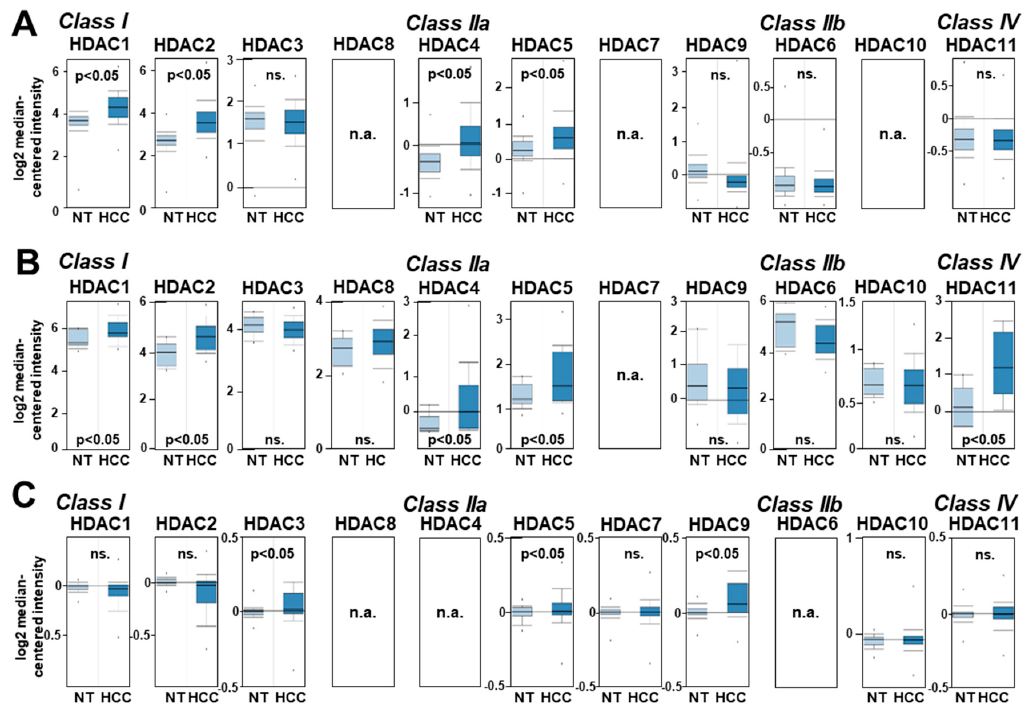
Figure 2. HDAC expression in human HCC compared with non-tumorous liver tissues. ( A–C ) HDAC mRNA levels in non-tumorous liver tissues (NTs) as compared to HCC tissues from patients. Data were obtained from the Oncomine TM cancer microarray database using the datasets ‘Roessler Liver2’ (n = 445) (C), ‘Wurmbach Liver’ (n = 75) (D), and ‘Guichard Liver’ (n = 185) (E). (*: p < 0.05 compared to non-tumorous tissue; n.a.: no data available.) Table 1. Correlation of HDAC mRNA vs. collagen I (alpha 1) (Col I) in non-tumorous human liver